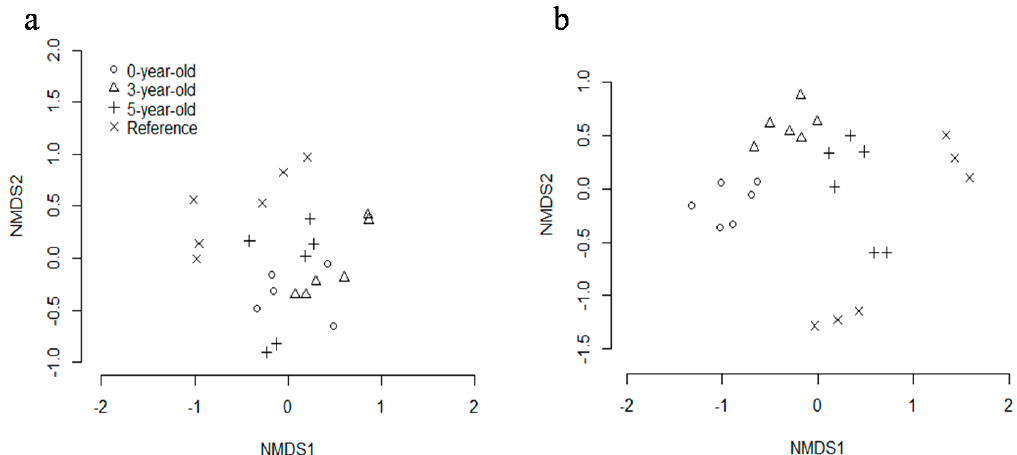
Figure 1. Non-metric multidimensional scaling (NMDS) ordination plot showing tree species composition in the ( a ) upland and ( b ) lowland areas. The NMDS was based on the Bray–Curtis similarity index computed using species abundance data.